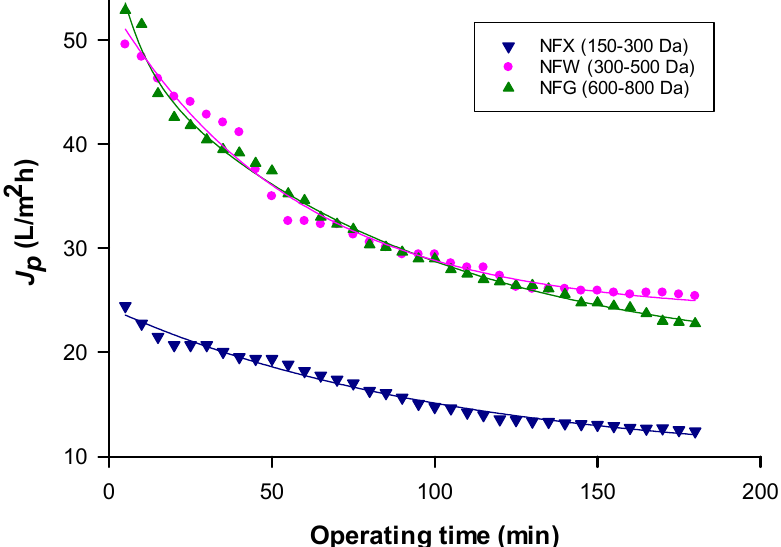
Figure 1. Time course of permeate flux ( J p ) for the investigated membranes. Operating conditions: Transmembrane pressure (TMP), 25 bar; Flow rate (Q f ), 245.5 L/min; Temperature (T), 30 °C.